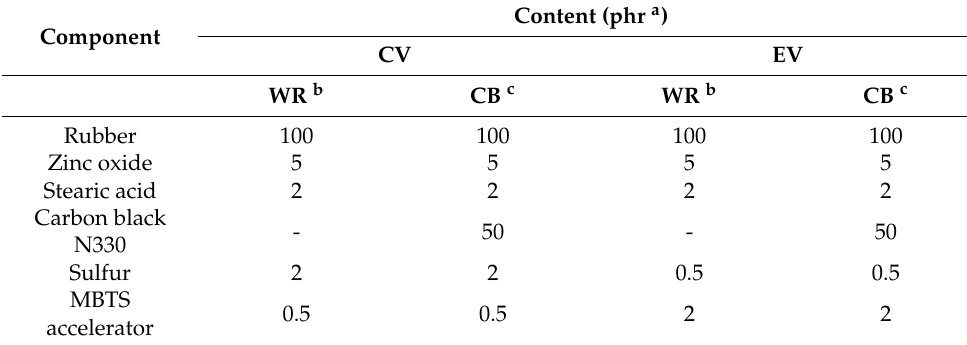
Table 1. Formulations of CV and